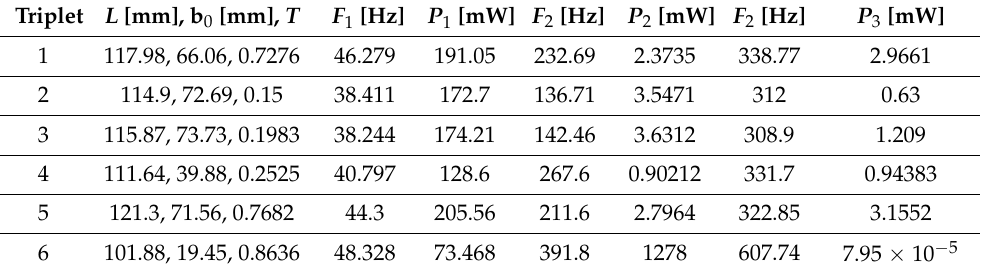
Table 5. The first three resonant frequencies and the related output powers for structures suggested by the optimization techniques listed in Table 4. F 1 , F 2 , and F 3 are the first three natural frequencies of the tapered PVEH. P 1 , P 2 , and P 3 are the output power generated at F 1 , F 2 , and F 3 , respectively. Triplet L [mm], b 0 [mm],